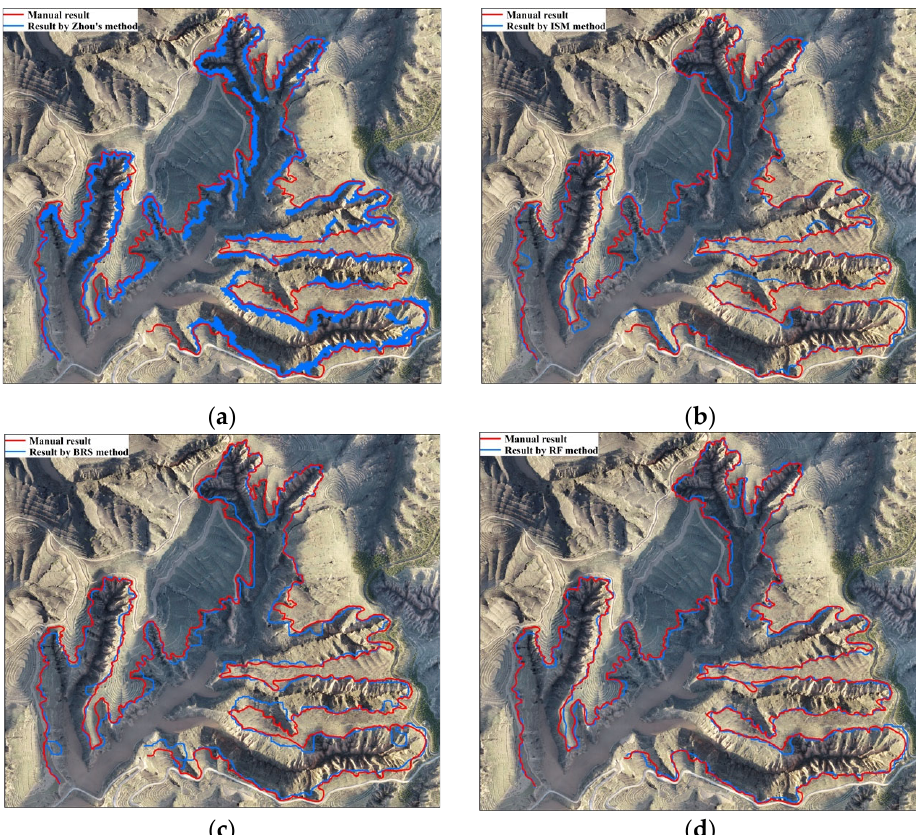
ISPRS Int. J. Geo ‐ Inf. 2023 , 12 , 140 Figure 13. Results of the di ff erent extraction methods. ( a ) Result of Zhou’s method; ( b ) result of ISM Figure 13. Results of the different extraction methods. ( a ) Result of Zhou’s method; ( b ) result of ISM method; ( c ) result of BRS method; ( d ) result of RF method. method; ( c ) result of BRS method; ( d ) result of RF method.